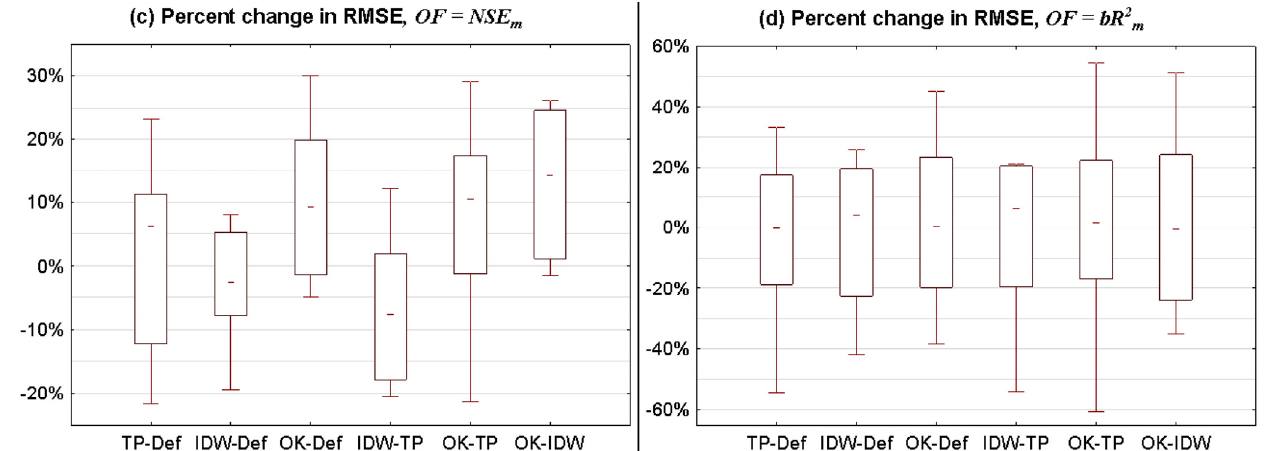
Figure 8. Box plots of percent changes in RMSE across all 11 flow gauging stations for different interpolation methods (Def—Default version, TP—Thiessen Polygons, IDW—Inverse Distance Weighted, OK—Ordinary Kriging) and different objective function/temporal aggregation combinations ( a — (cid:1840)(cid:1845)(cid:1831)